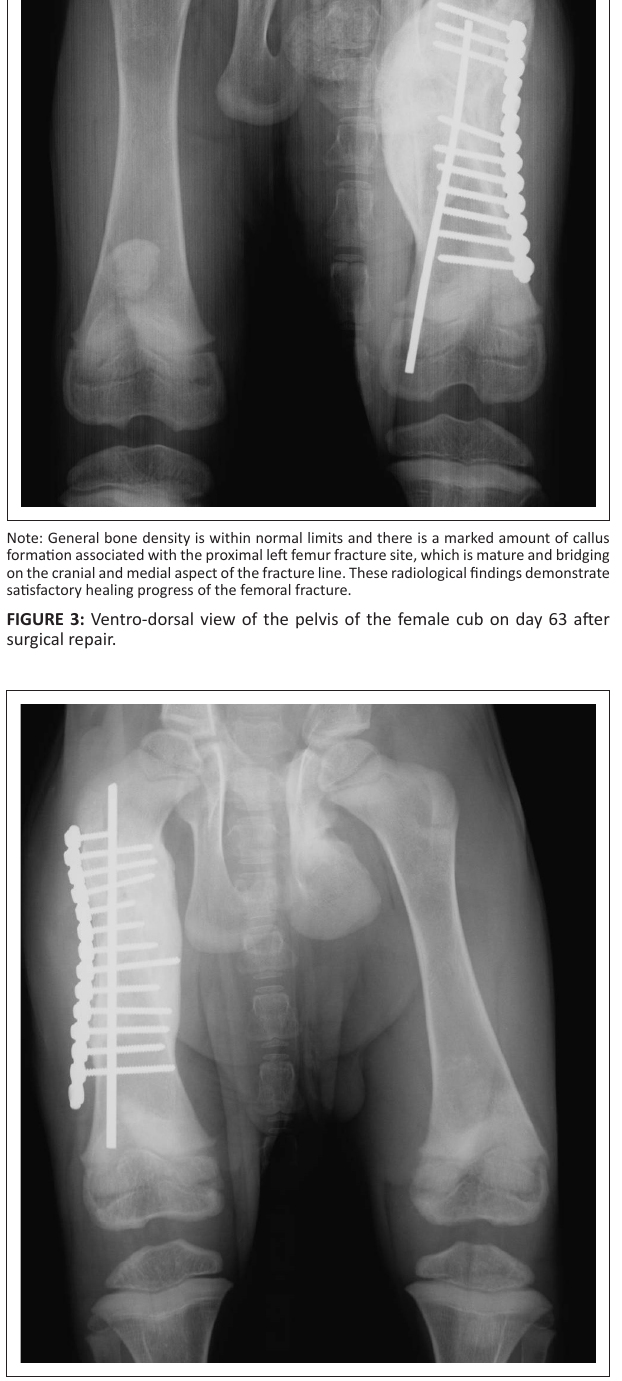
FIGURE 4: Ventro-dorsal view of the pelvis of the male cub on day 63 after surgical